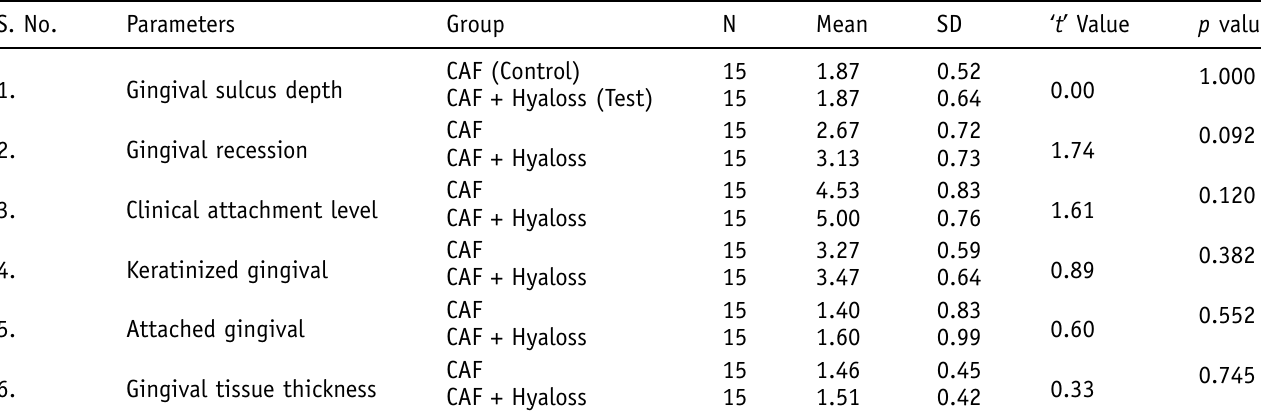
Table I. Comparative analysis of parameters at baseline between the two groups control (CAF) and the test (CAF + Hyaloss) group. S. No.